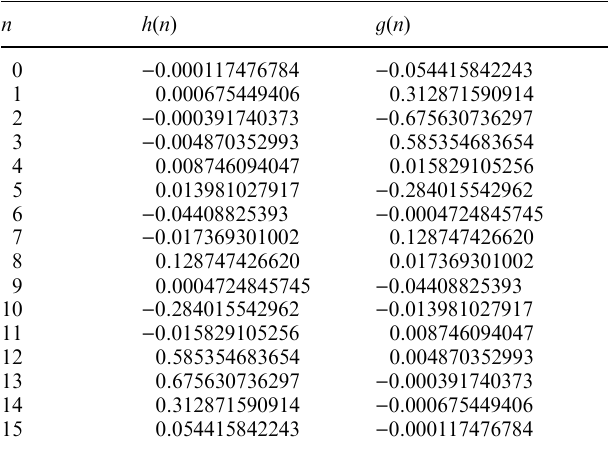
Table 3. The DB8 coe(cid:129)cients associated with analysis FIR filters ( h ( n )) and ( g ( n )) n h ( n ) g ( n